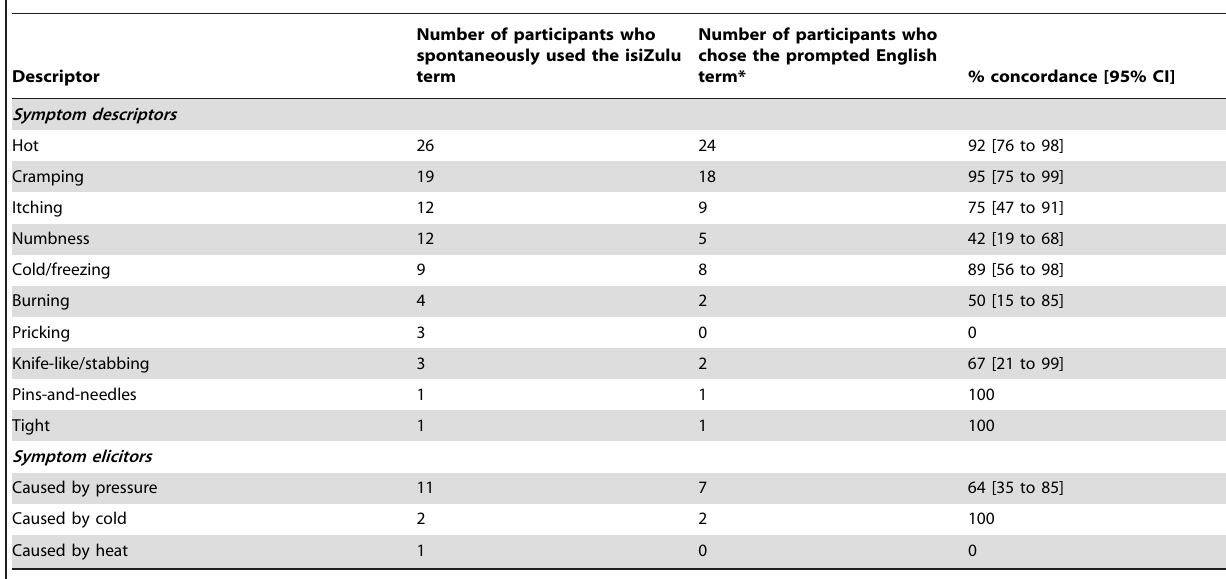
Table 6. Concordance between spontaneously used isiZulu terms and English terms chosen from a list of neuropathic symptom